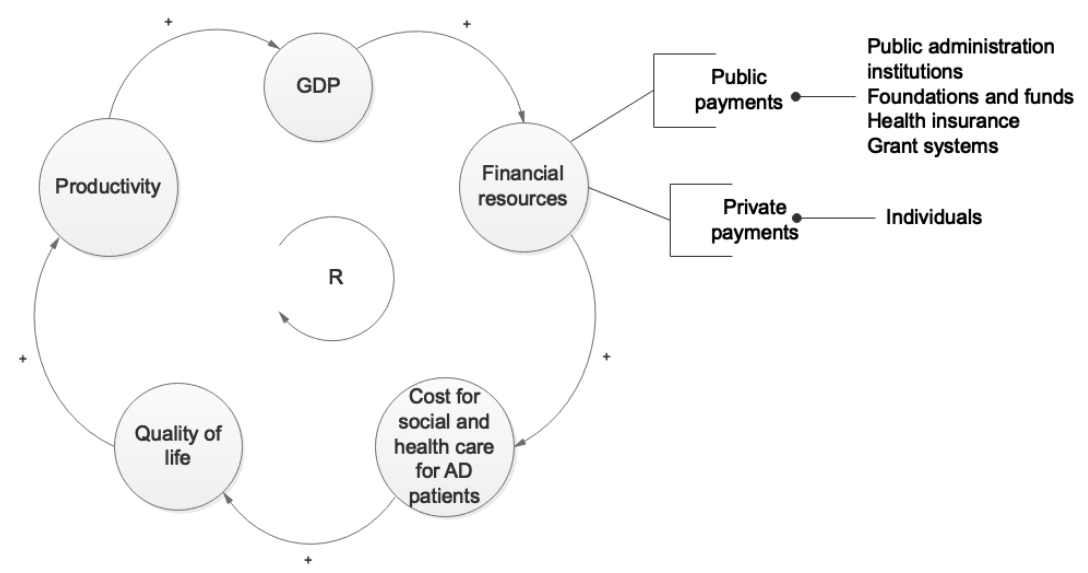
Figure 6. Causality in the health and social